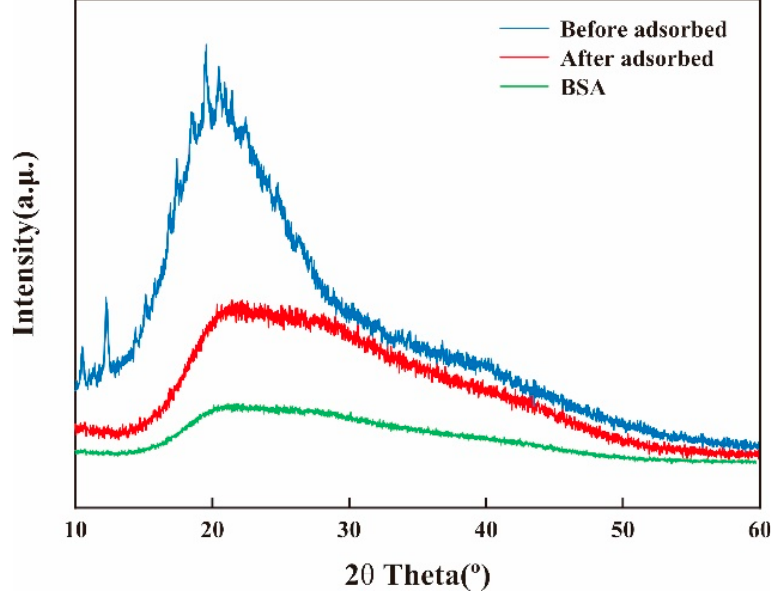
Figure 5. Changes of XRD before and after adsorption of BSA on the membrane.